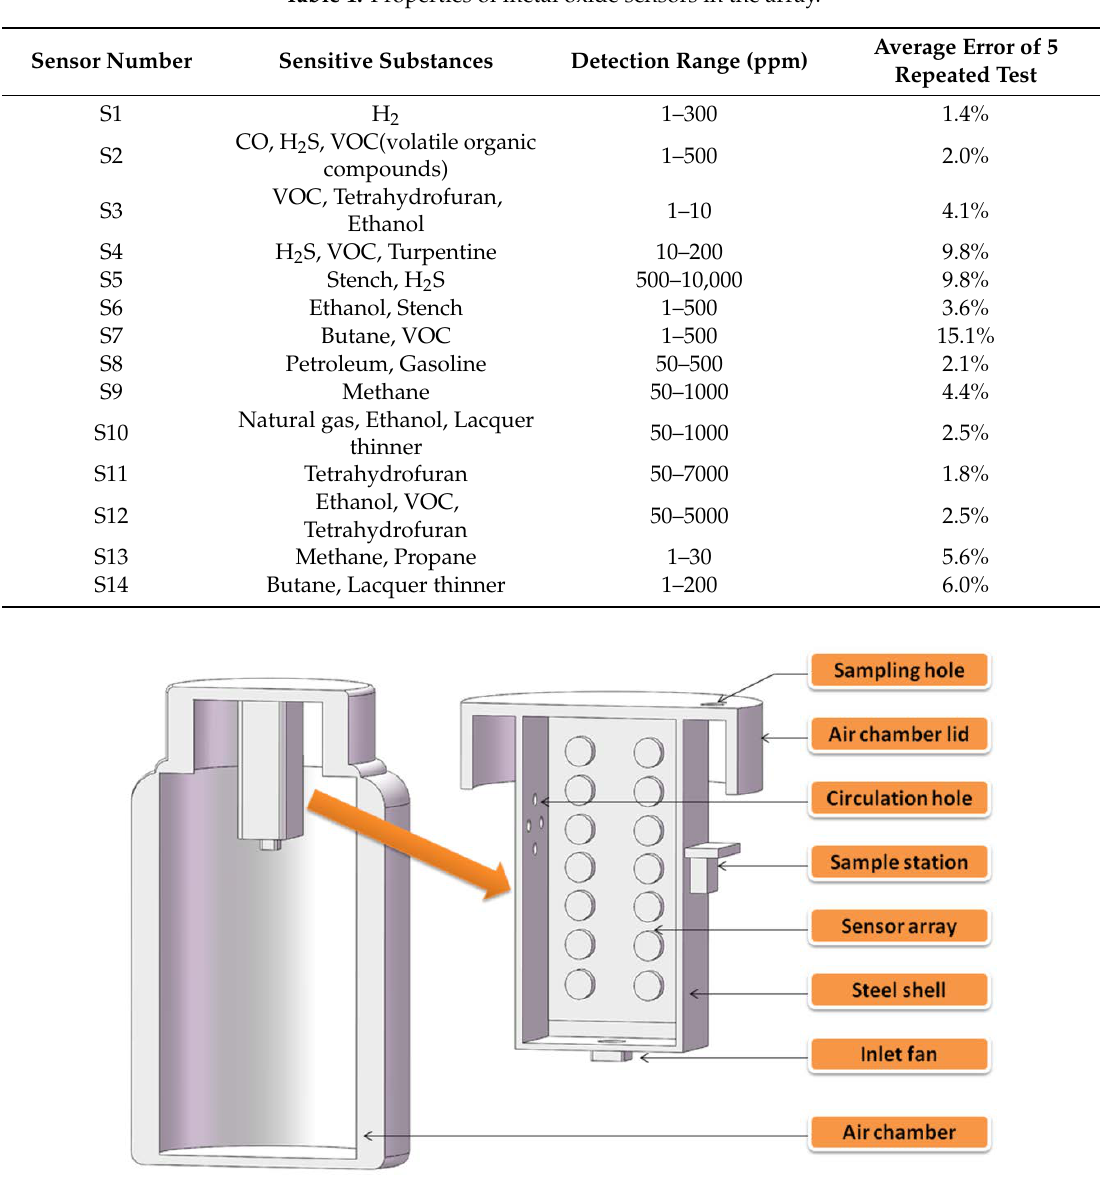
Figure 1. Cross-sectional diagram of the gas chamber and our E-nose.